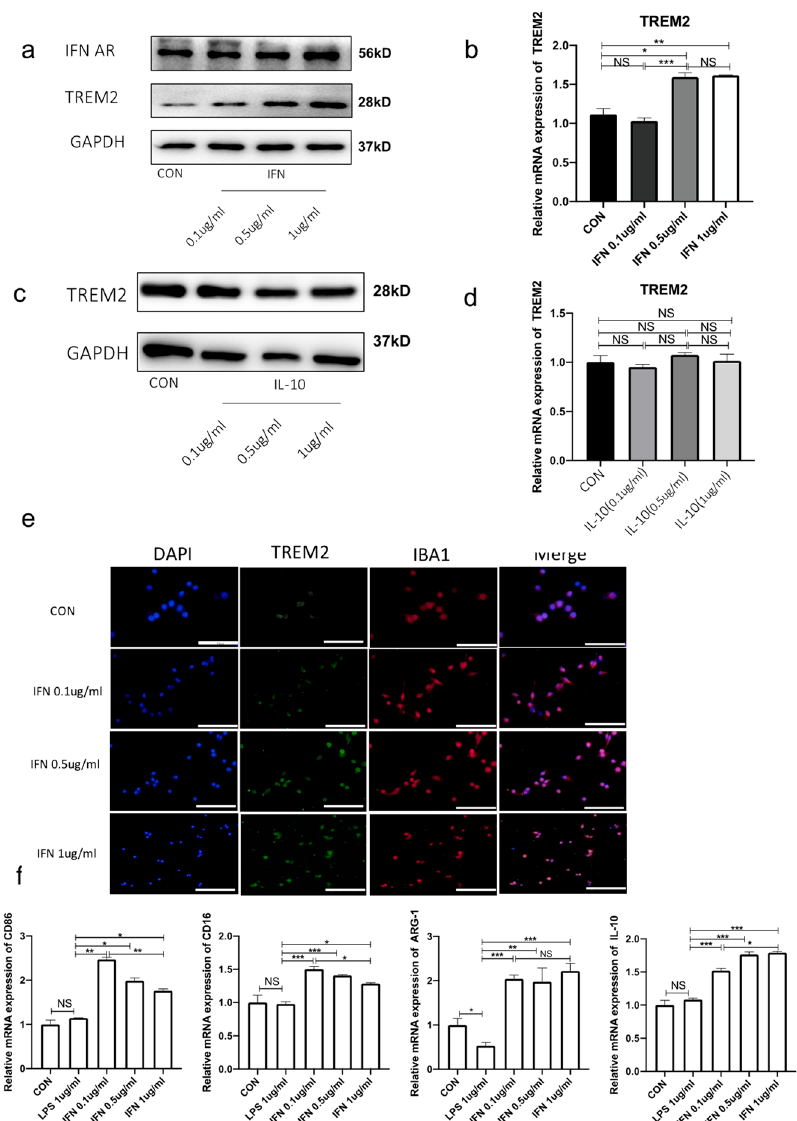
Figure 6. IFN- β increases TREM2 expression and promotes microglia polarization toward M2 phenotype. ( a ) Protein levels of TREM2 after different concentrations of IFN- β . ( b ) mRNA expression of TREM2 after different concentrations of IFN- β by PCR. ( c ) Protein levels of TREM2 after different concentrations of IL-10. ( d ) mRNA expression of TREM2 after different concentrations of IL-10 by PCR. ( e ) Immunofluorescence staining of brain sections from each group. Iba-1 indicates activated microglia (Red). ( f ) mRNA expression of M1-type microglia markers (CD16 and CD86) and M2-type microglia markers (ARG-1 and IL-10) by PCR. NS indicates no statistical difference from the control group. * p < 0.05, ** p < 0.03, *** p < 0.01 compared with control, n = 6 mice per group.